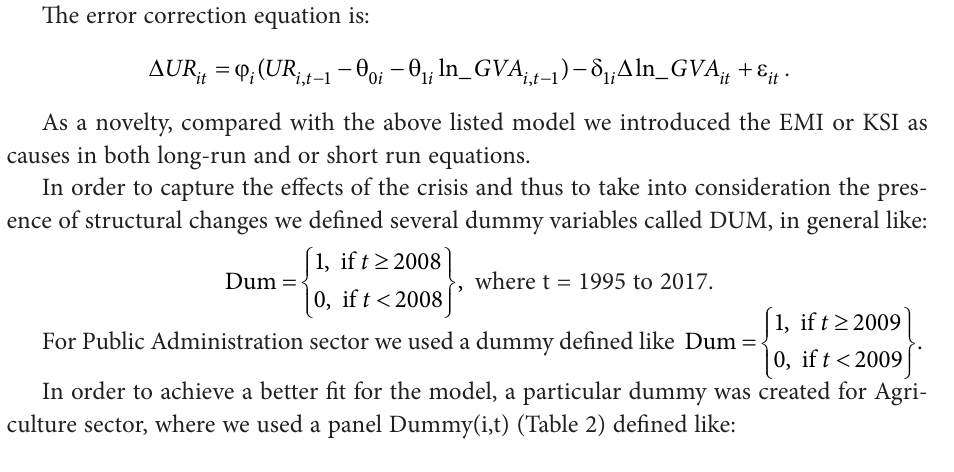
Table 2. Dummy variable for agriculture